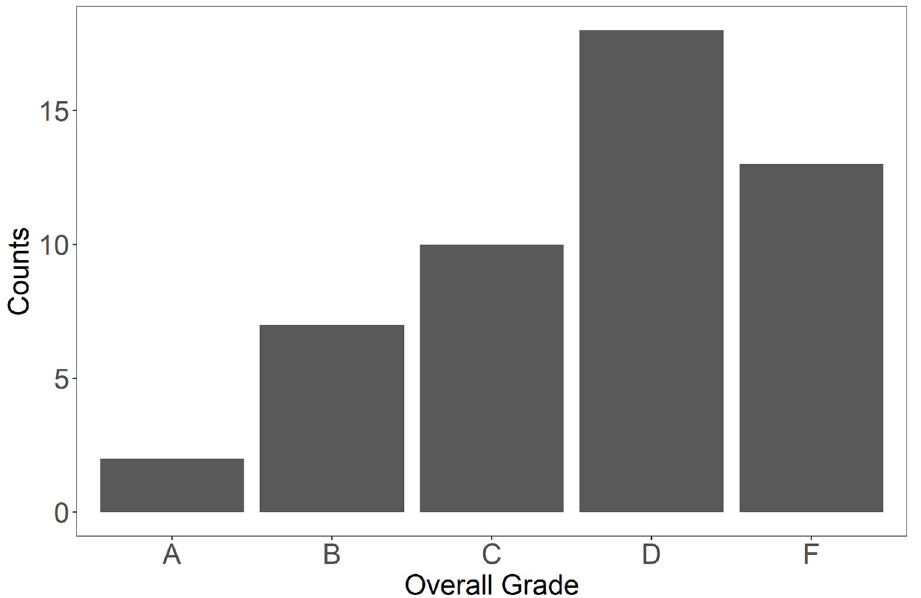
Fig 1. Count of institutions receiving each overall grade.